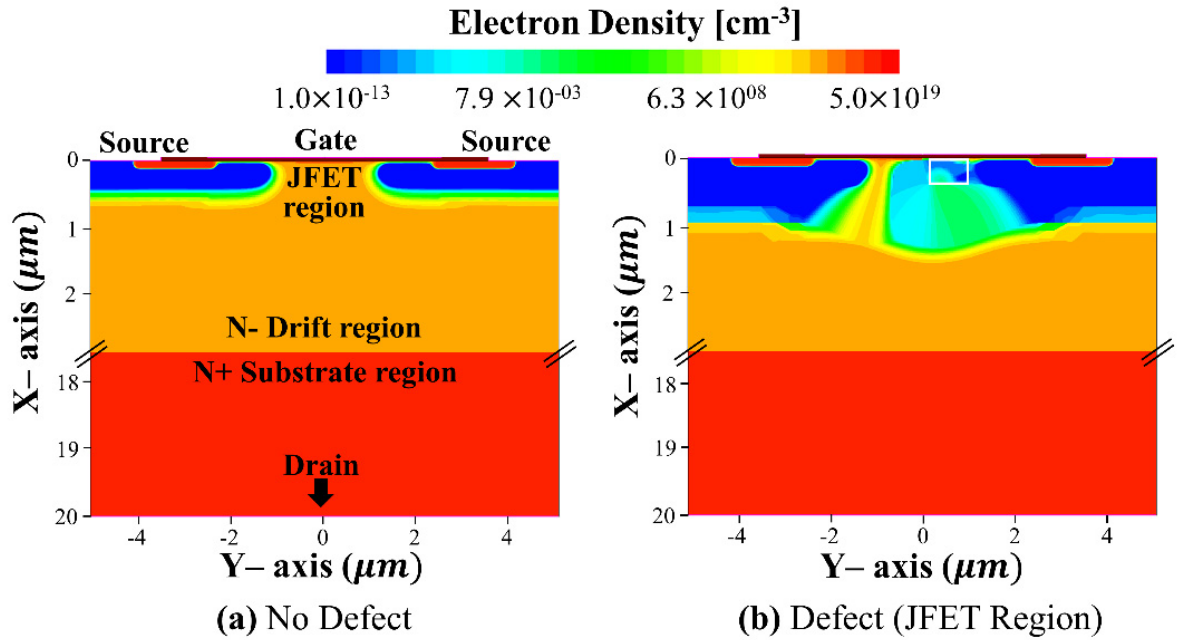
Figure 8. Electron density profiles of SiC MOSFETs ( a ) with no defect and ( b ) with accepter-like defect (white line box). The bias condition is at V GS = 20 V and V DS = 0 V, when the time is 1.7 × 10 − 6 µs.